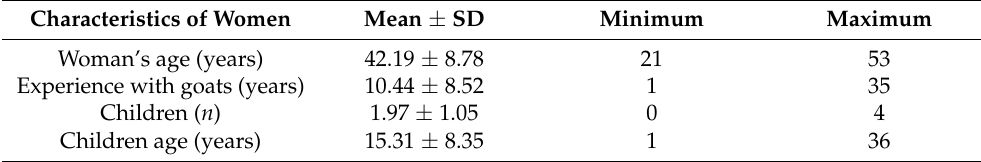
Table 2. Characteristics of the profile of livestock farmer women (mean ± SD). Characteristics of